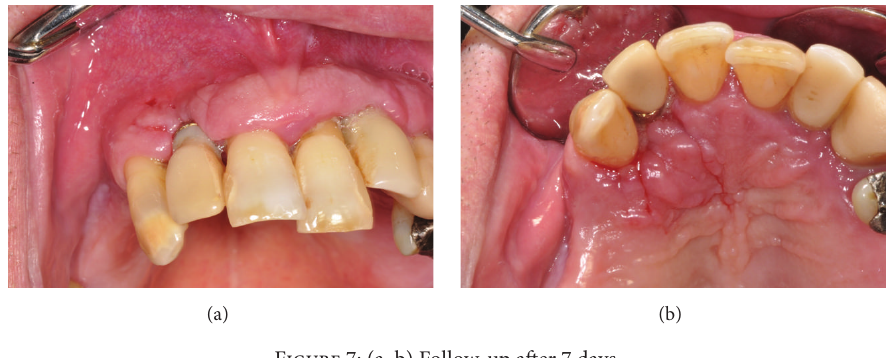
Figure 7: (a, b) Follow-up after 7 days.